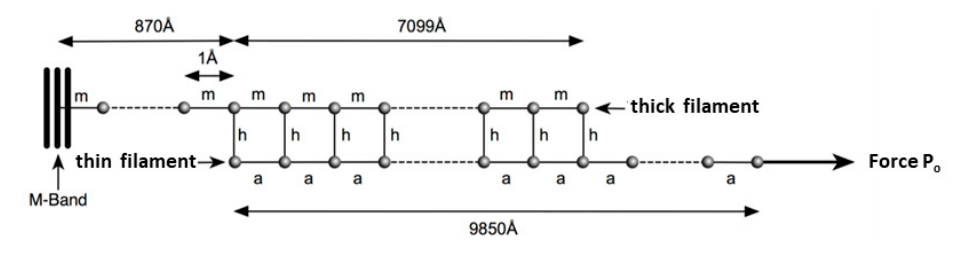
Figure A3. Discrete model approximating the continuous model by Ford et al. [4]. The values chosen for the thin filament (a), thick filament (m) and head stiffness (h) are given in the text.